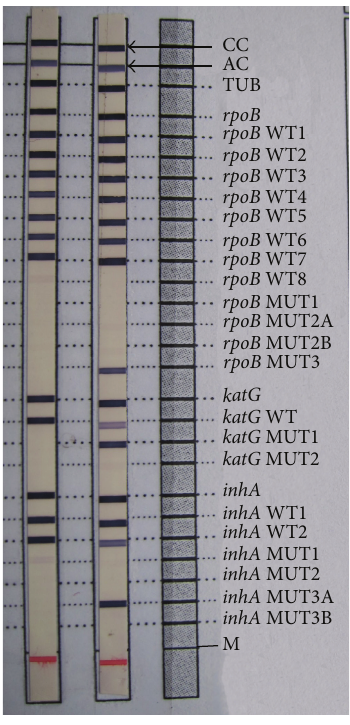
Figure 3: (From left to right) Lane 1: sensitive pattern. Lane 2: MDR TB patient with rpoB MUT3 band indicating rifampicin resistance and katG MUT1 band and inhA MUT3A band along with wild type band indicating INH heteroresistance. Lane 3: reference strip.